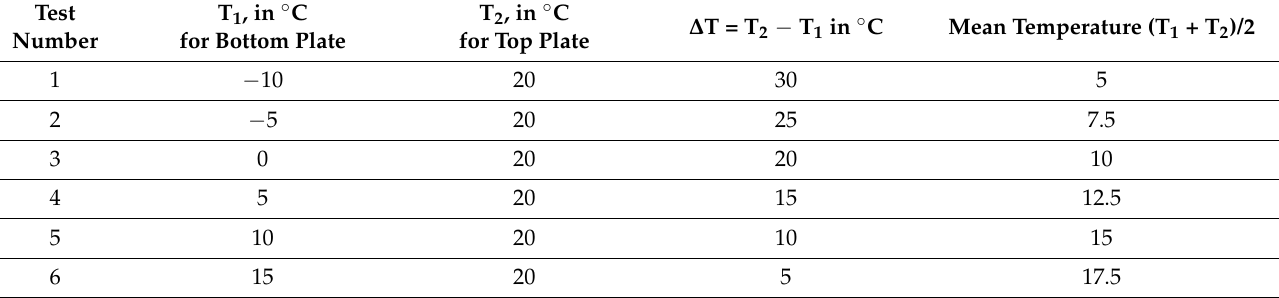
Table 3. Temperature configuration